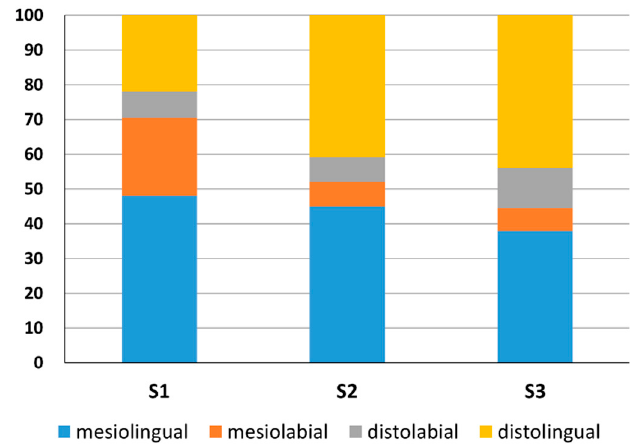
Figure 8. The relative frequency (%) of the directions with the thinnest dentin. S1: apical third; S2: middle third; S3: coronal third.